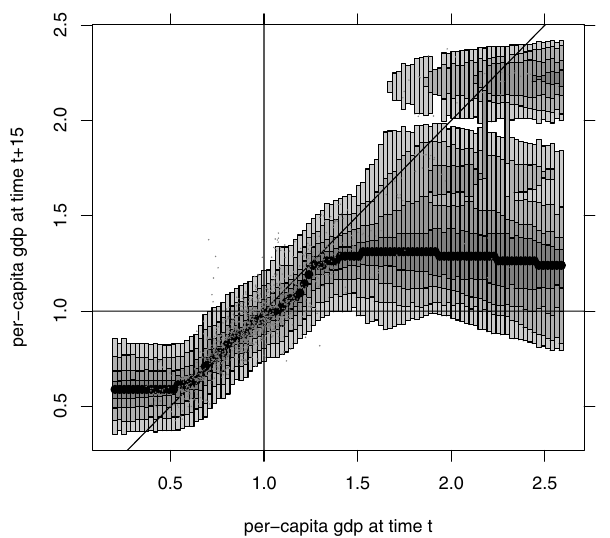
Figure 4 – Intra-Distribution Dynamics of regional per-capita income in Europe. HDR plot of conditional density for transitions of 15 years between 1980-2002. Estimates are based on a kernel density estimator with a variable bandwidth in the x direction (span = 0.15) and a fixed bandwidth in the y direction (b =